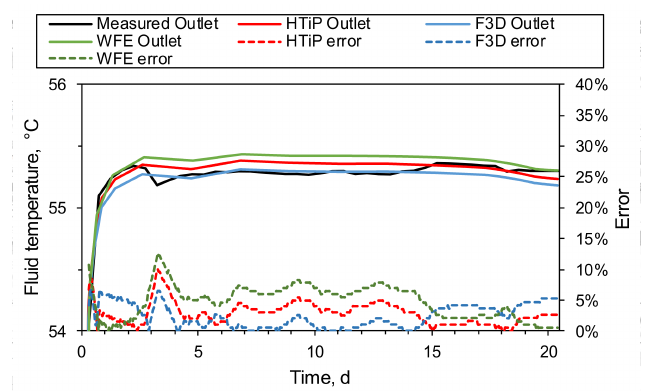
Figure 8. Comparison between the measured (black) and simulated temperatures of the fluid at the BHE outlet (solid) and the relative error (dashed) for the HTiP, F3D, and WFE modelling